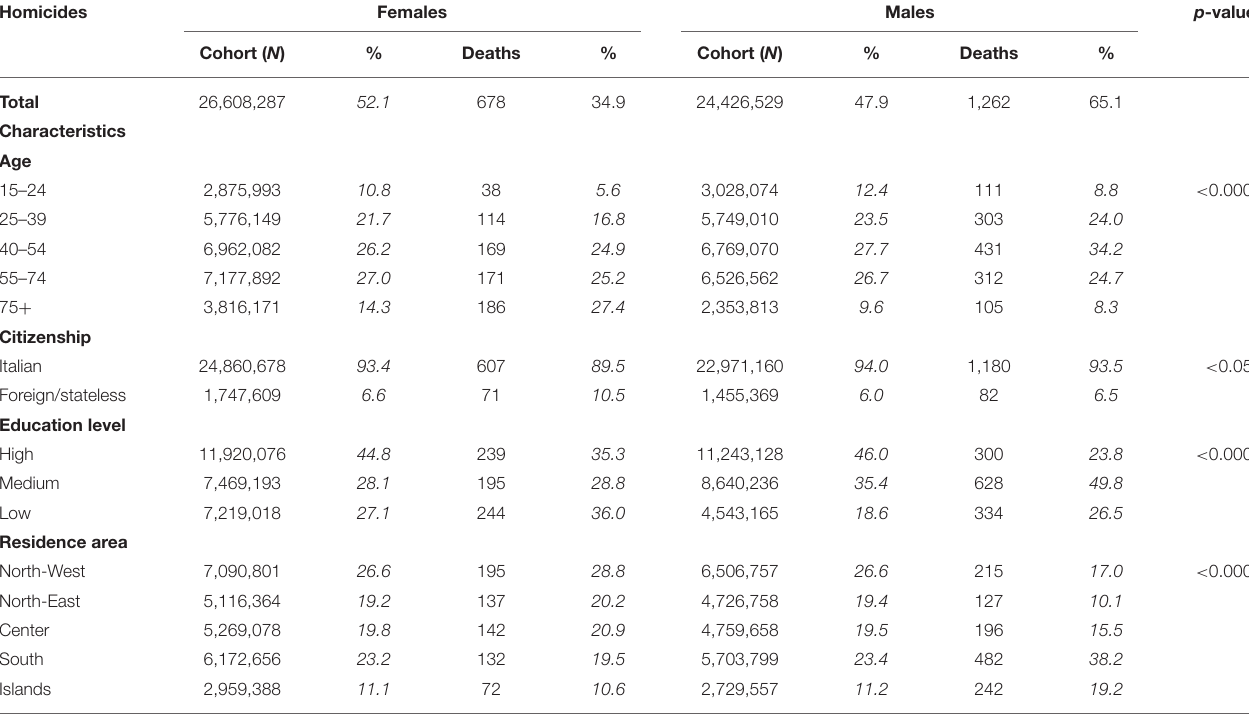
TABLE 1 | Characteristics of the cohort at the beginning of follow-up and of the deaths, by sex, 2012–2018. Homicides